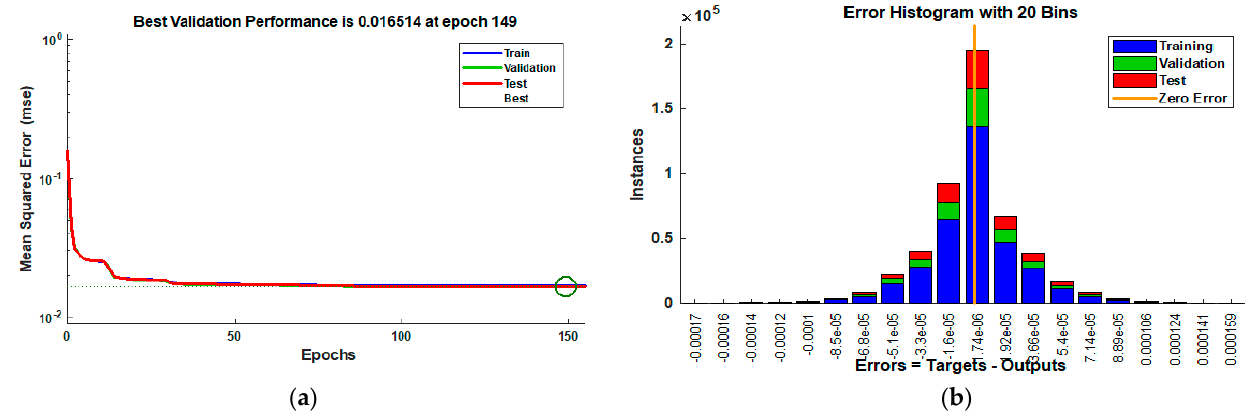
Figure 8. ( a ) Validation performance of proposed system. ( b ) NARX method histogram MSE. Table 4. Training Outcomes by Means of Proposed NARX Controller.